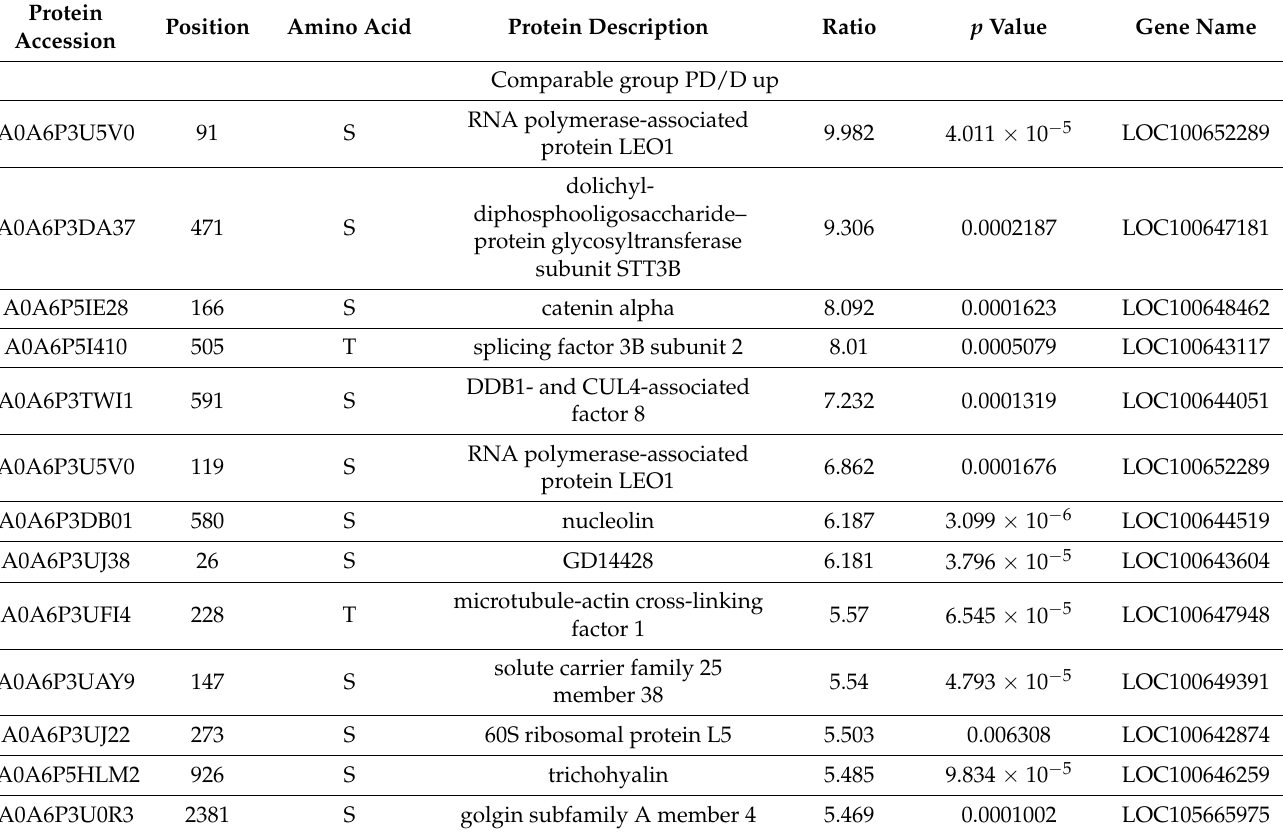
Table 2. The upregulated DEPPs in PD/D and FPD/PD with fold changes higher than